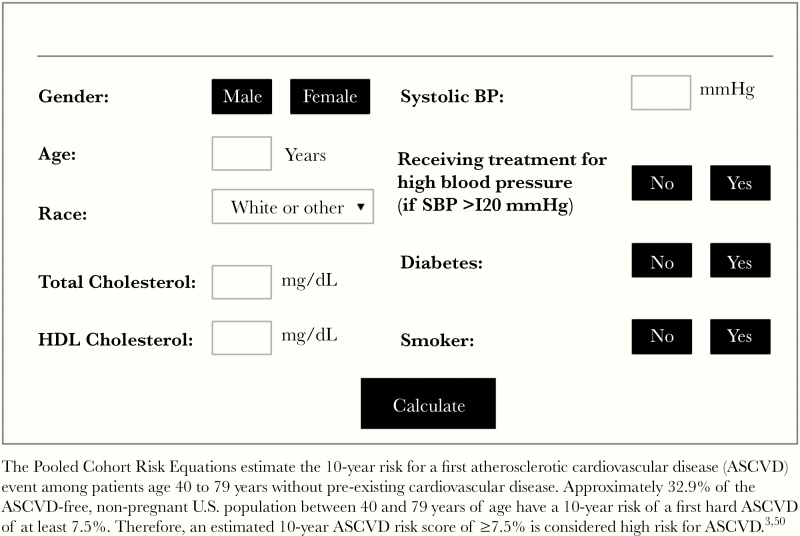
American College of Cardiology/American Heart Association (ACC/AHA) 2013 Pooled Cohort Risk Equations. BP, blood pressure; HDL, high-density lipoprotein; SBP, systolic BP.